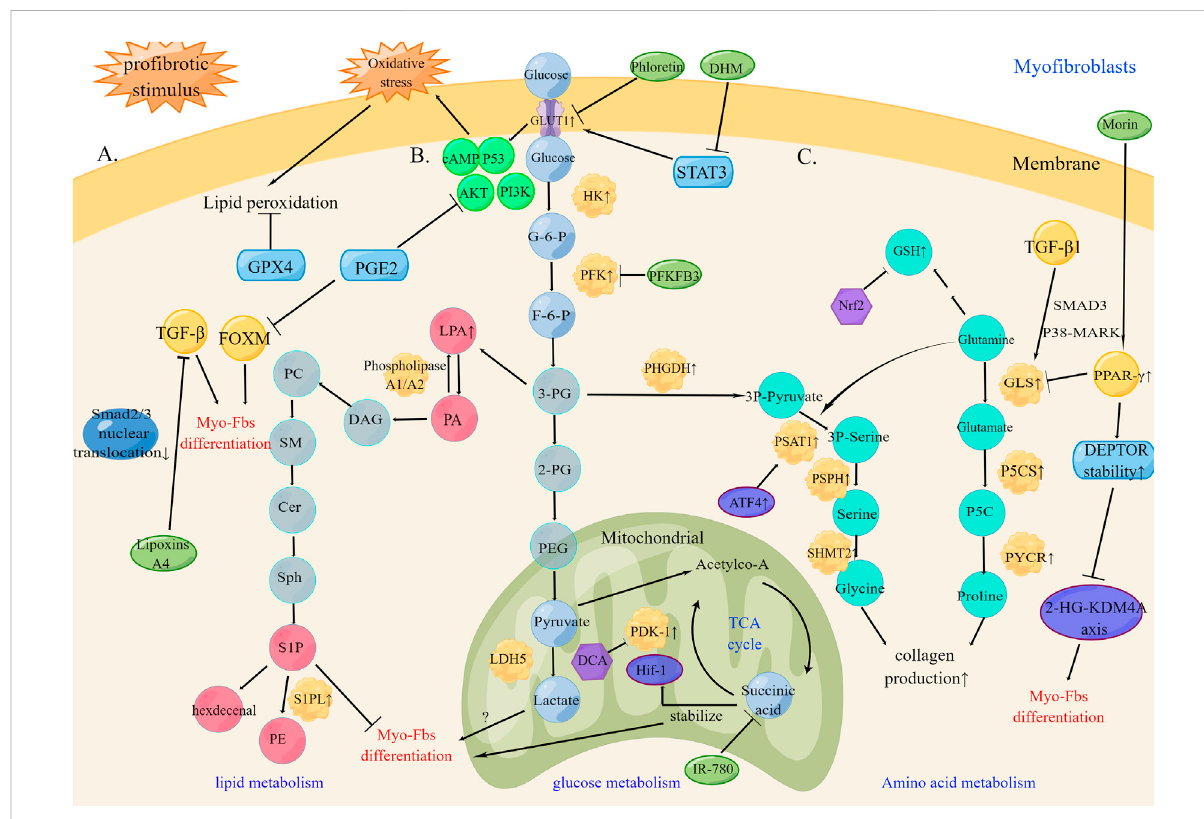
FIGURE 1 Metabolic reprogramming of myo fi broblasts in pulmonary fi brosis (A) . Under pro fi brotic stimulus, lipid metabolism increases phospholipid synthesis and lipid peroxidation products. The therapeutic targets GPX4, PGE2, and TGF- β can inhibit myo fi broblasts differentiation (B) . Under pro fi broticstimulus, increasedaerobicglycolysisup-regulatesHK,PFK,andPDKandGLUT1expressionbychangesinmetabolic statusandoxidative stress promote myo fi broblasts differentiation into myo fi broblasts by the HIF-1 α /PDK1 axis. The therapeutic targets PFKB3, PDK1, and succinic acidcaninhibitmyo fi broblastsdifferentiation (C) .Underpro fi broticstimulus,aminoacidmetabolismpromotesglutaminolysisandincreasesGlycine and GSH production leading to collagen production. The therapeutic targets PPAR- γ and DEPTOR stability can inhibit collagen production and myo fi broblasts differentiation. PC, Polycarbonate; SM, sphingomyelin; Cer, ceramide; Sph, sphingosine; DAG, Diacylglycerol; HK, hexokinase; G-6- P, glucose-6-phosphate; PFK, phosphofructokinase; F-6-P, fructose-6-phosphate; 3-PG, 3-phosphoglycerate; 2-PG, 2- phosphoglycerate; PEG, phosphoenolpyruvate; DCA, Dichloroacetate; TCA cycle, tricarboxylic acid cycle; 3P-pyruvate, 3-phosphohydroxy-pyruvate; 3P Serine, 3- phosphohydroxy-serine; PHGDH, phosphoglycerate dehydrogenase; PSAT1, phosphorylated serine aminotransferase 1; PSPH, phosphorylated serine phosphatase; SHMT2, serine hydroxymethyltransferase 2; P5CS, Δ 1-pyrroline-5-carboxylic acid synthase; PYCR, pyrroline-5-carboxylate